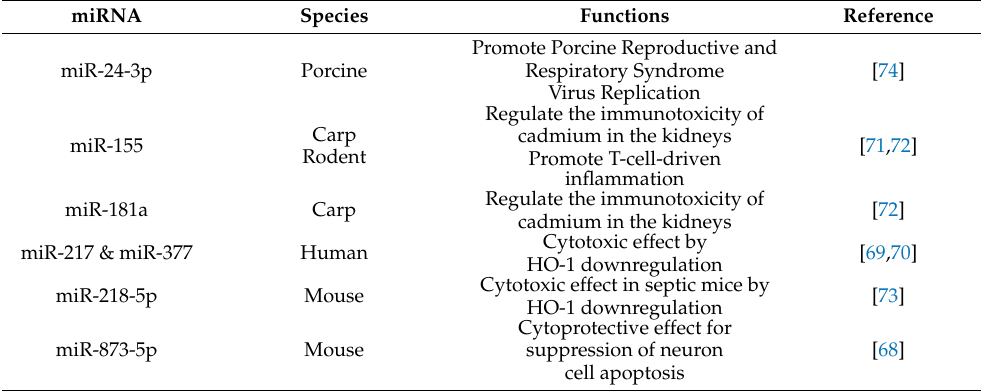
Table 1. HO-1 targeting miRNAs and their